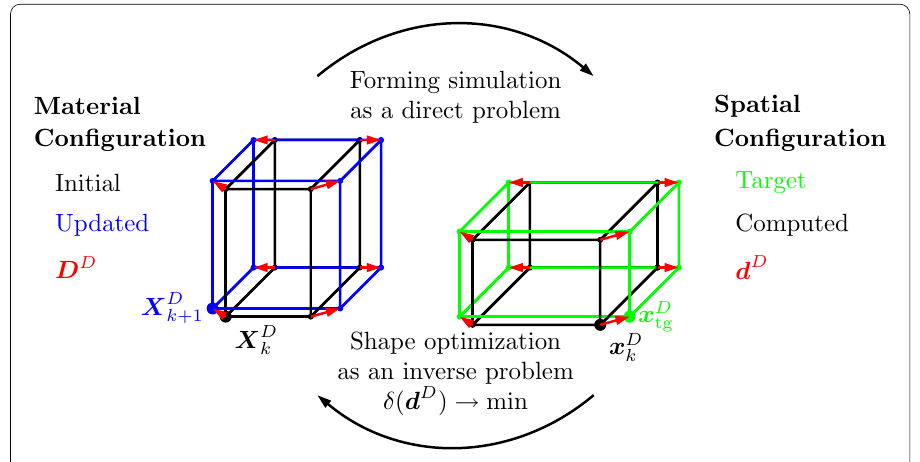
Fig. 1 Inverse shape optimization procedure with material configuration, target spatial configuration and the computed spatial